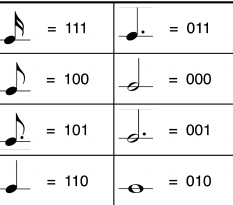
Figure 24. Two-dimensional PQCA codes for waits and durations.